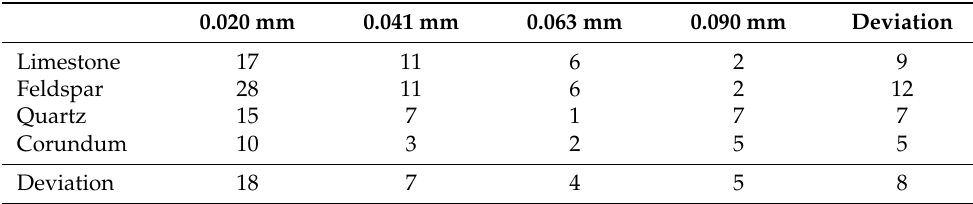
Table 12. Absolute deviation between k VTI (SA) and k VTI (LG) (%).